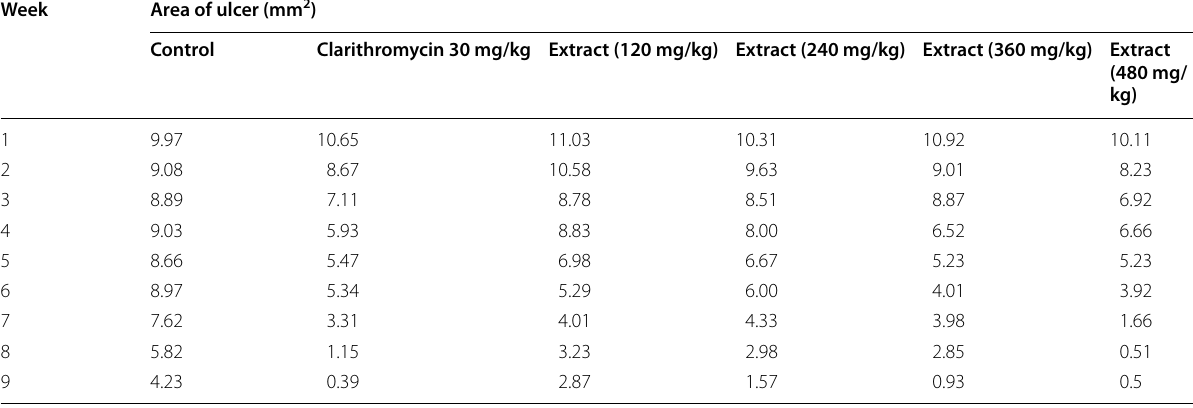
Table 6 Effect of C. zeylanica extract on area of ulcer naproxen-induced H. pylori -infected therapeutic ulcers Week Area of ulcer (mm 2